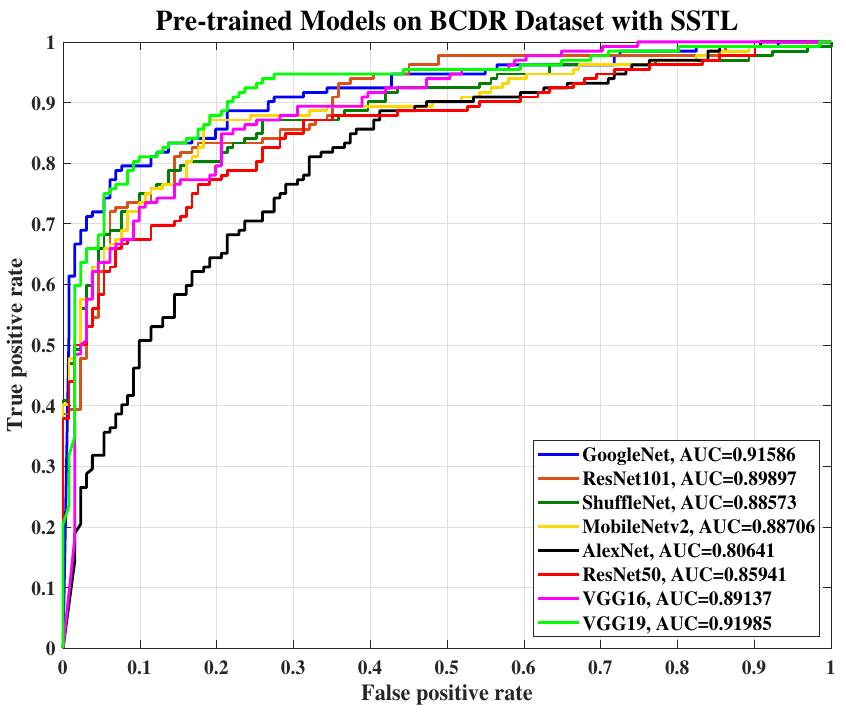
Figure 9. The ROC curve of various pre-trained models with SSTL for breast cancer classification using the BCDR